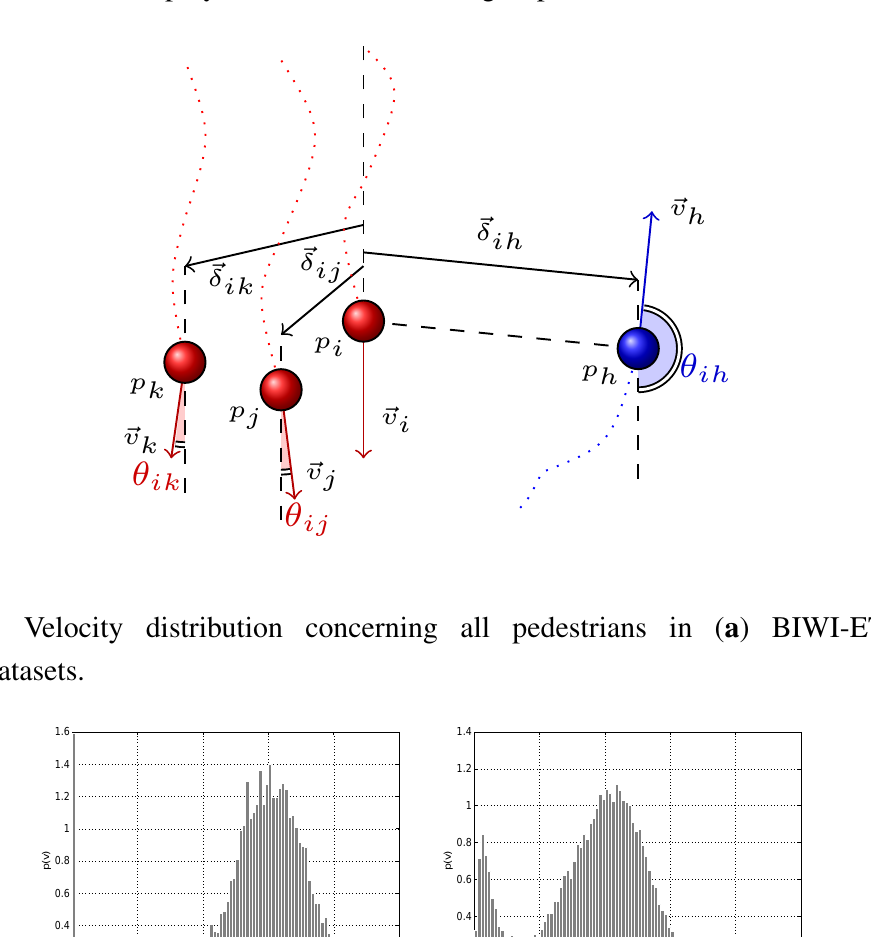
Figure 3. Pedestrians of same group are denoted with same color. Some positional and directional measures employed in identification of groups are illustrated in reference to p